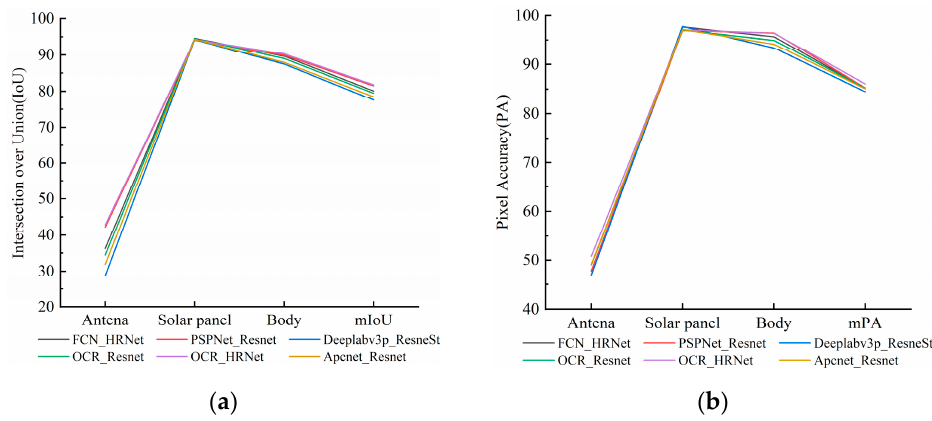
Figure 12. Various types of segmentation accuracy and overall accuracy obtained by training of the spacecraft dataset and validation of the real-shot validation dataset: ( a ) intersection over union; ( b ) pixel accuracy.